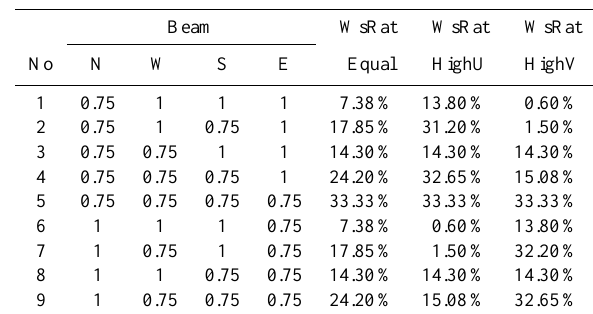
Table 3. Lidar beam averaging cases and their effects in percentages depending on beam in